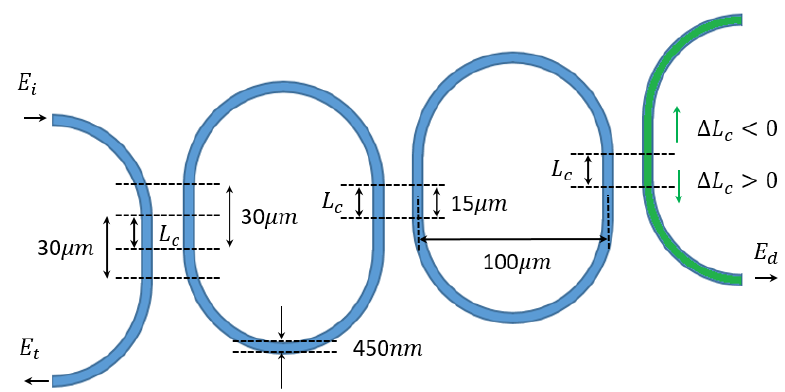
Figure 12. The optical circuitry design of the